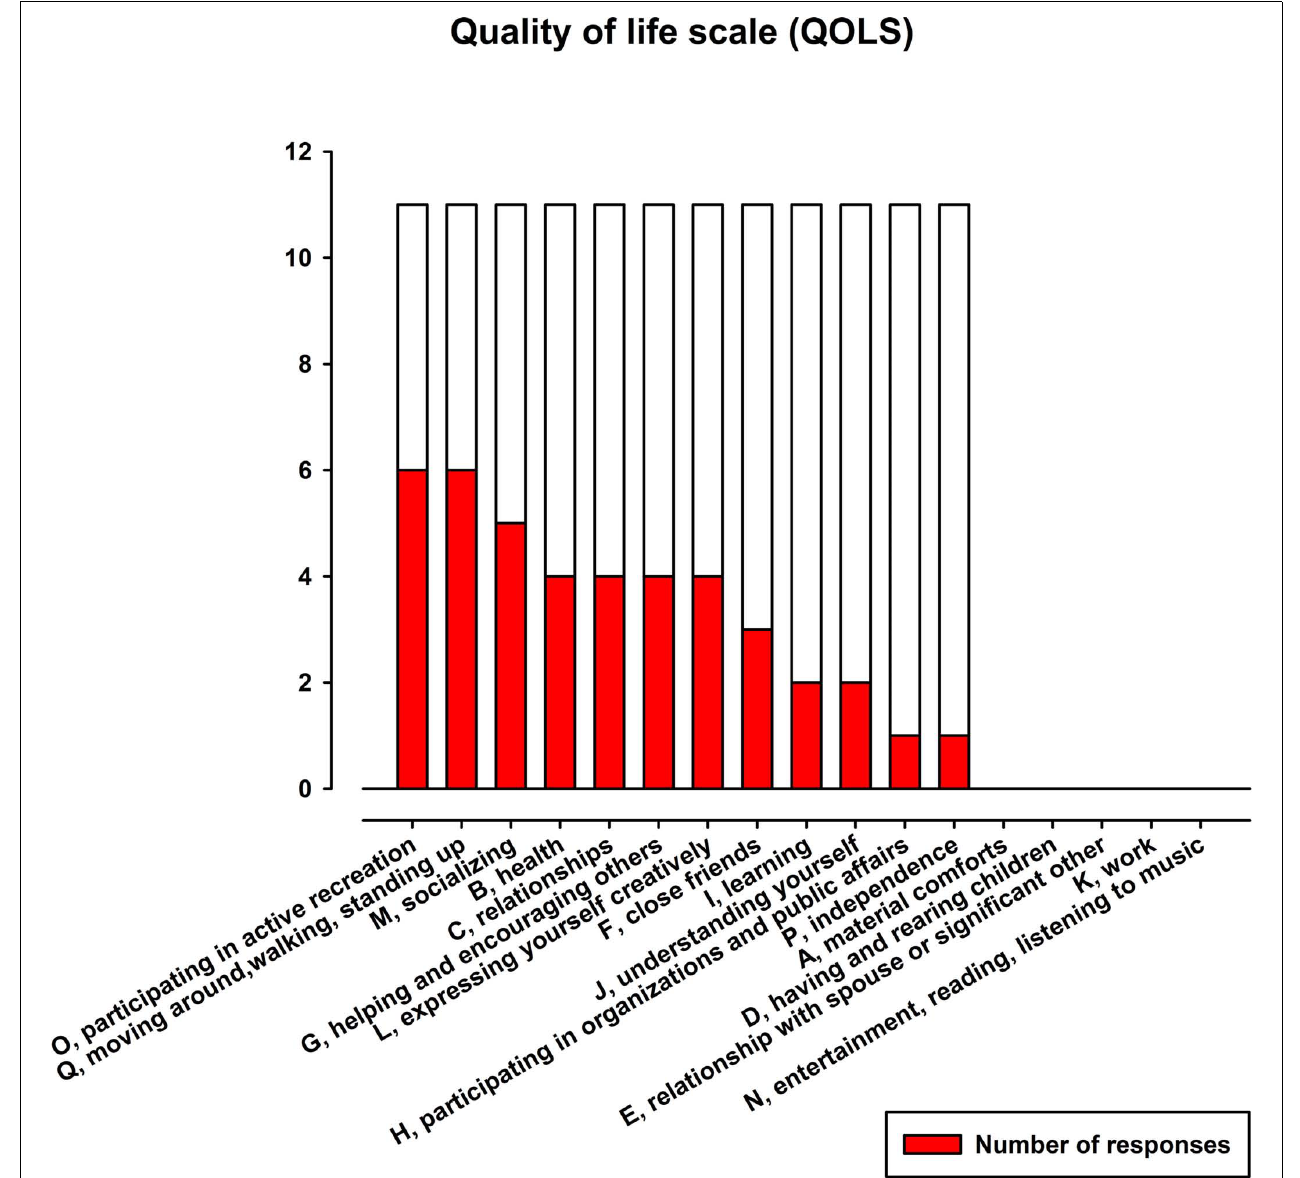
FIGURE 3 |Absolute frequencies of the items of QOLS. Note that the items are represented in order from highest number of improvement responses to lowest.